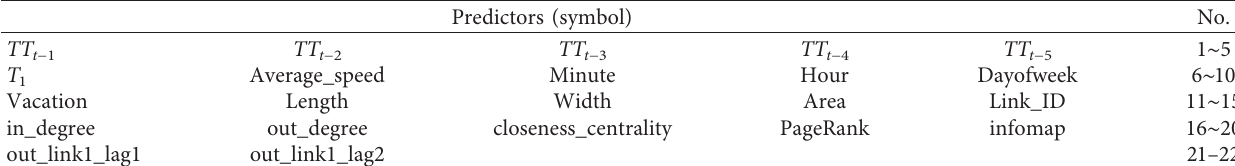
Table 3: The key spatio-temporal features of the traffic